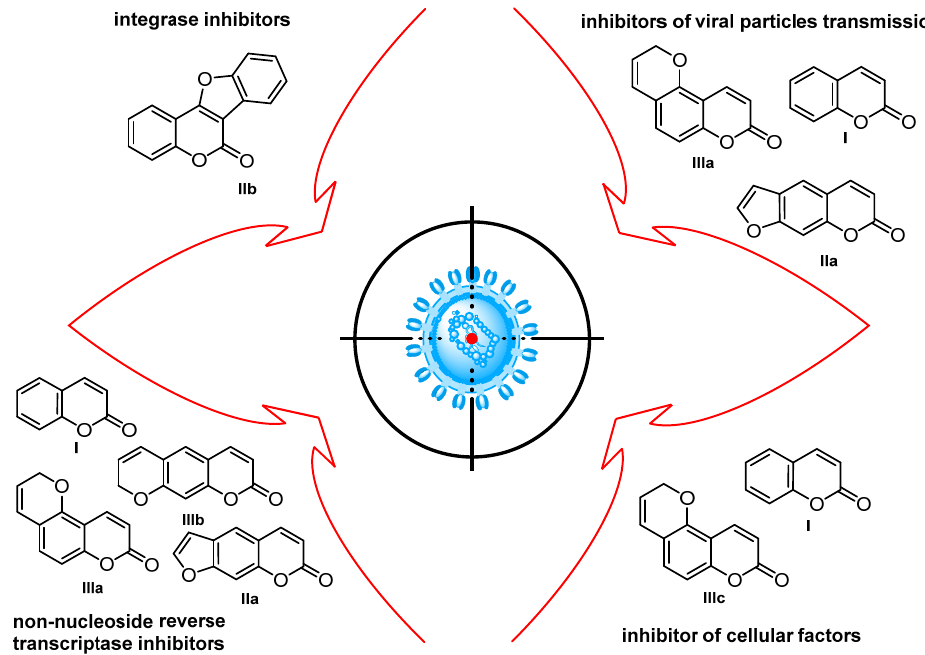
Figure 2. Molecular targets for naturally occurring anti-HIV coumarins.